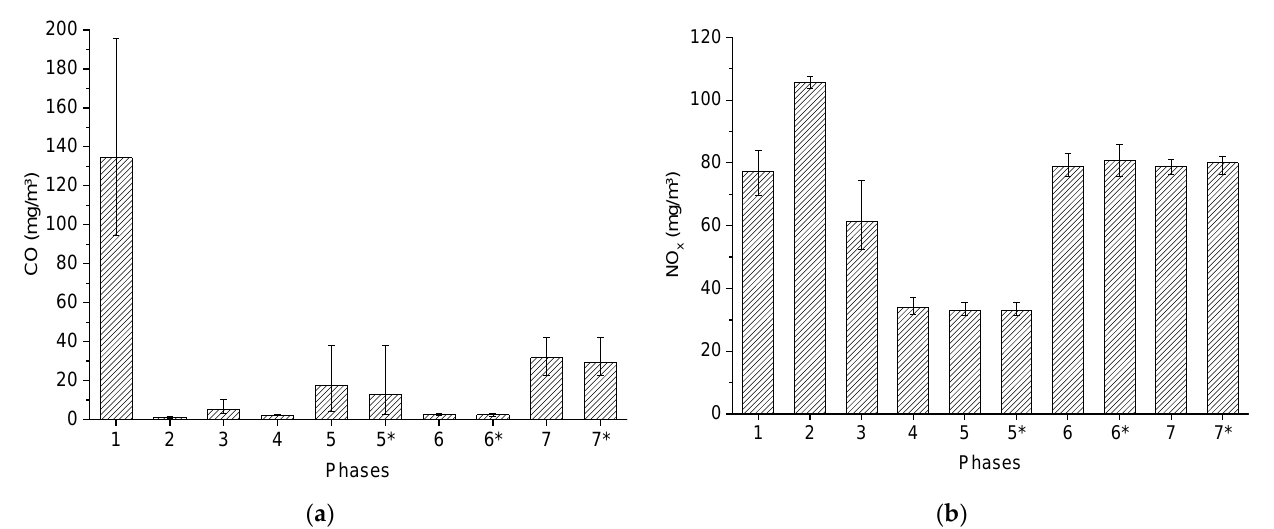
Figure 3. Average gaseous emissions for the different process phases (error bar: min./max. values; * incl. values for calculated auto-switch-off (Exp. 1 and Exp. 2)); ( a ) CO ( b ) NO x for standardized 13 vol. % O 2 content in dry flue gas (STP).